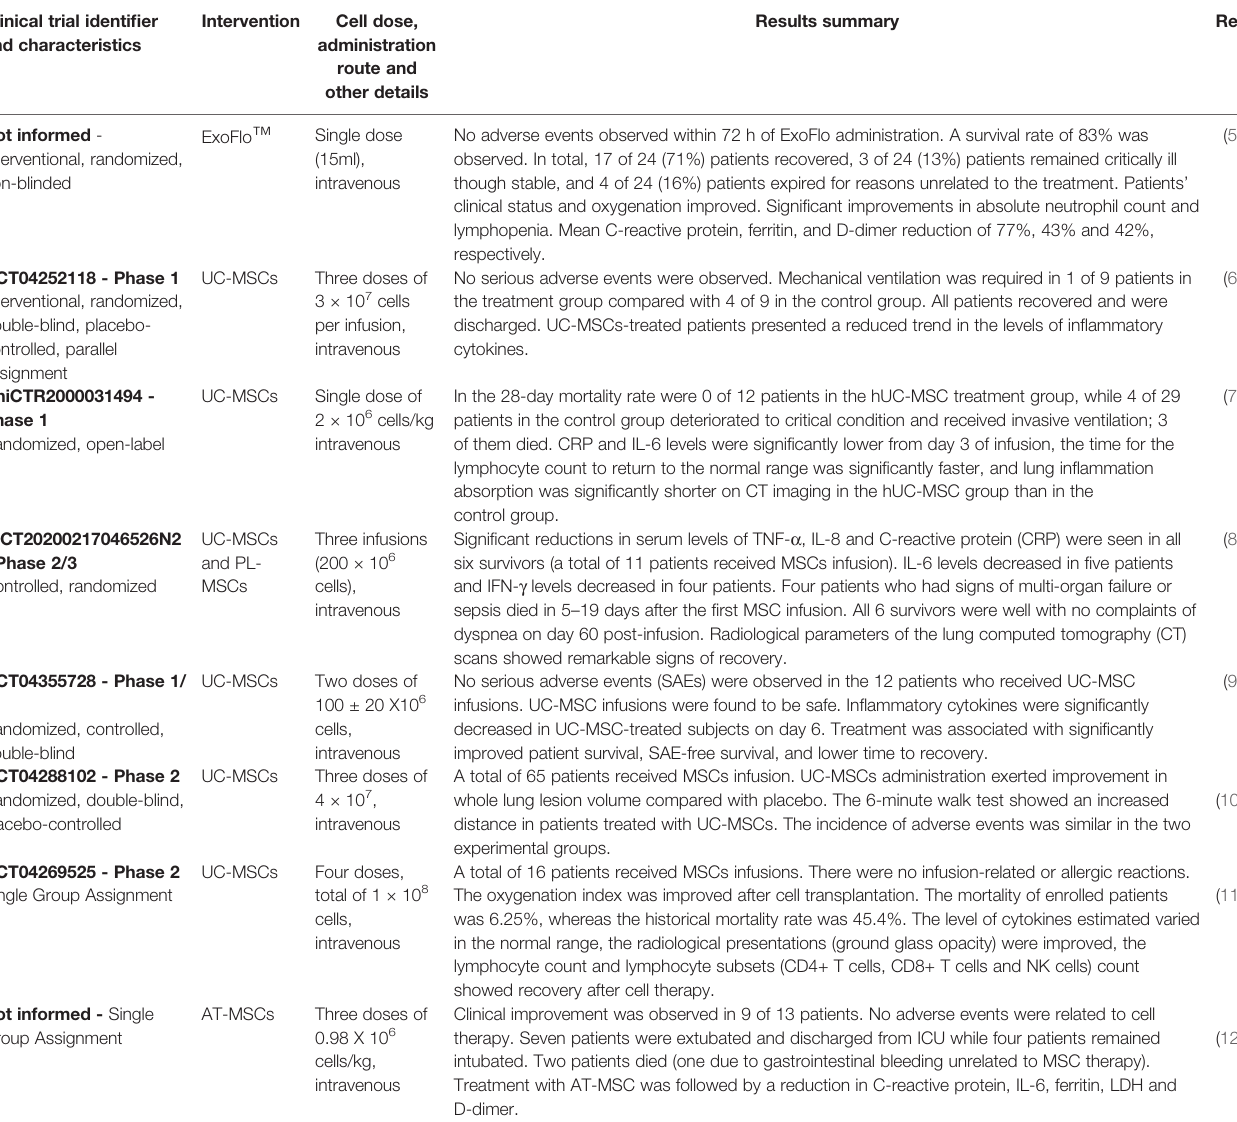
TABLE 1 | Results of stem cell treatments for COVID-19 since June 2020. Clinical trial identi fi er and